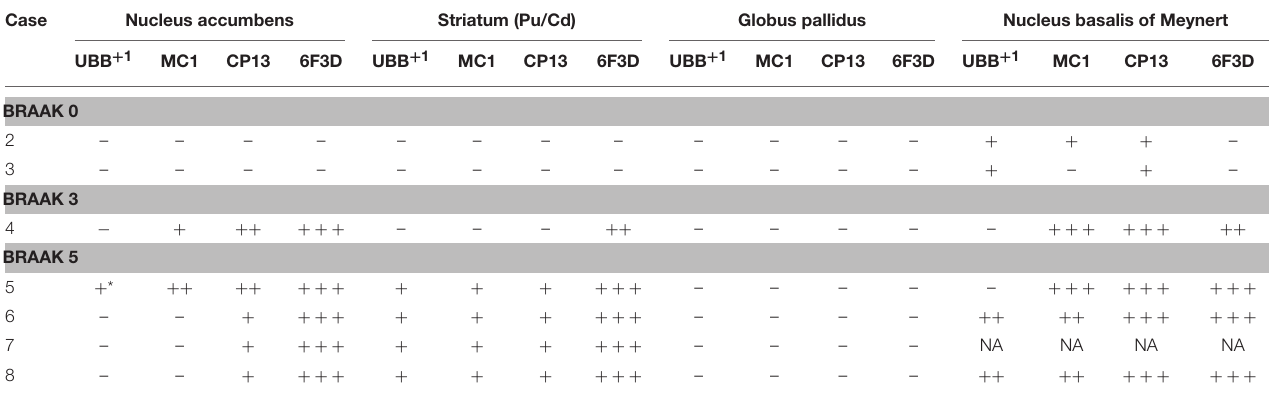
TABLE 4 | Immunoreactivity for UBB + 1 , pre-tangle material (MC1), tangles (CP13), and plaques (6F3D) in vibratome sections of the basal ganglia of controls (Braak stage 0), intermediate phase (Braak stage 3) and AD patients (Braak stage 5).